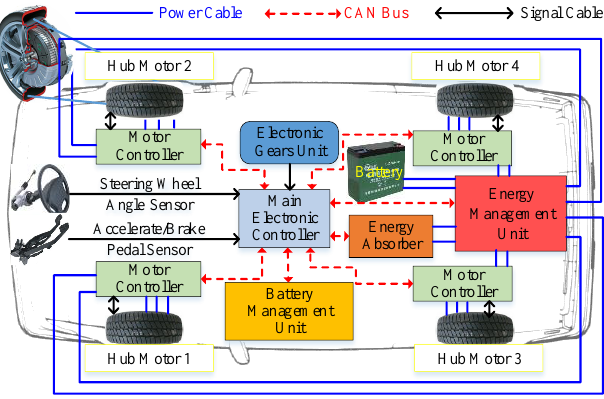
Figure 1. System Configuration of the 4MIDEV.